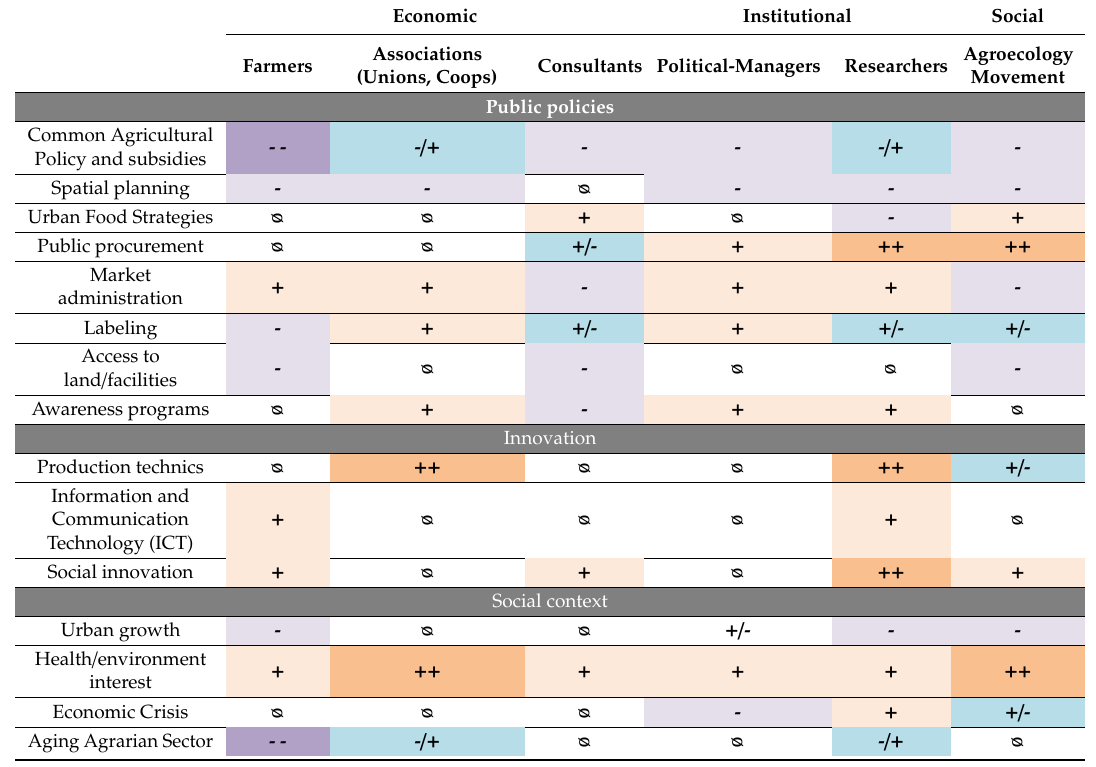
Table 1. Factors that exert an influence on farming dynamics according to